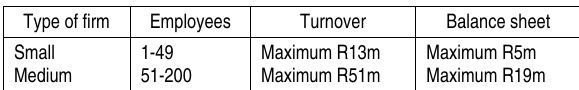
Table 1. Quantitative definition of SMMEs in South Africa . Type of